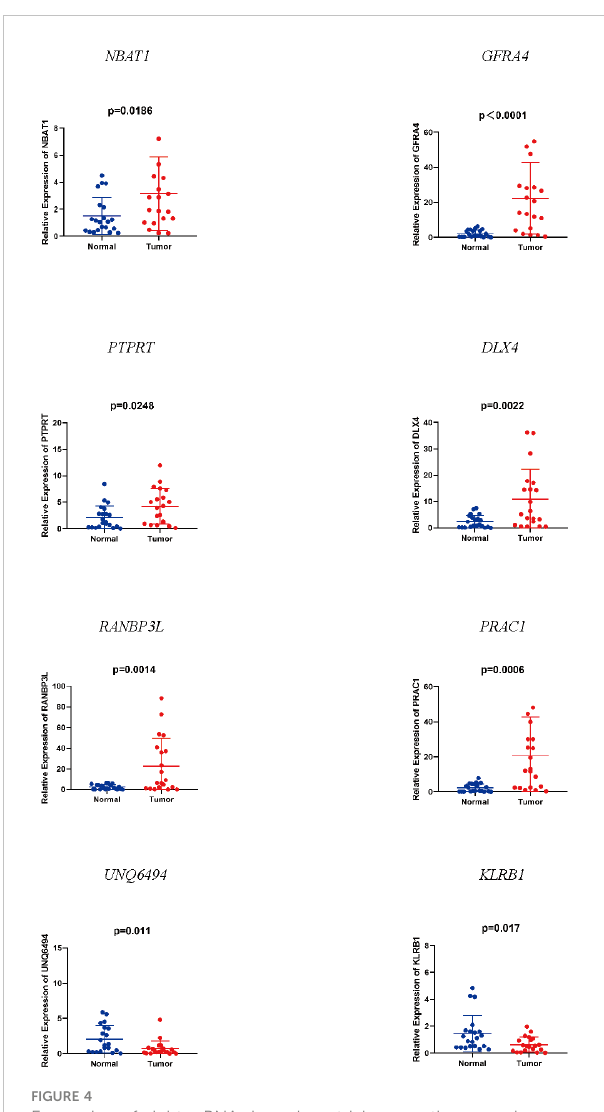
FIGURE 4 Expression of eight mRNAs in endometrial cancer tissues and normal